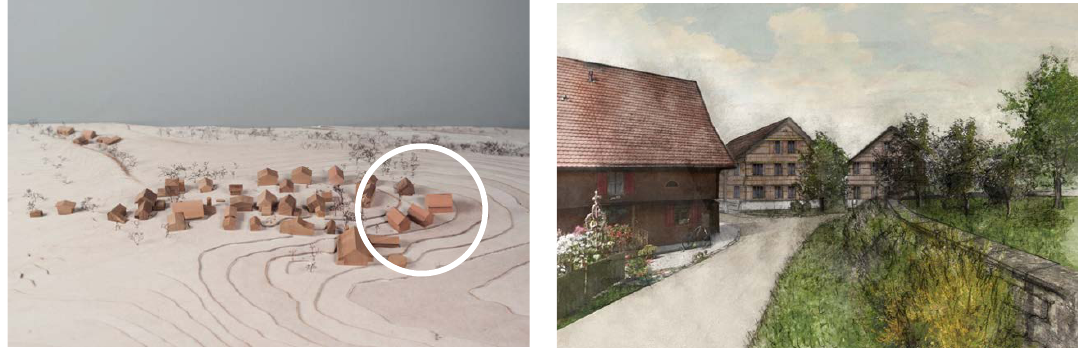
Figure 14. Development proposal for an old barn Figure 15. Development proposal for an old